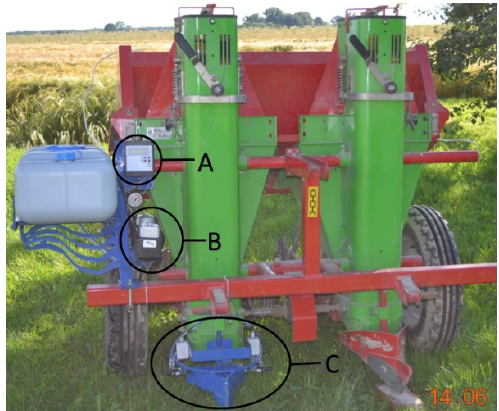
Figure 9. Dressing equipment converted into a KORA planter (UNIA company): A— solenoid valve controller; B—compressor; C—the position for placing the solenoid valve with an auxiliary airstream [38].